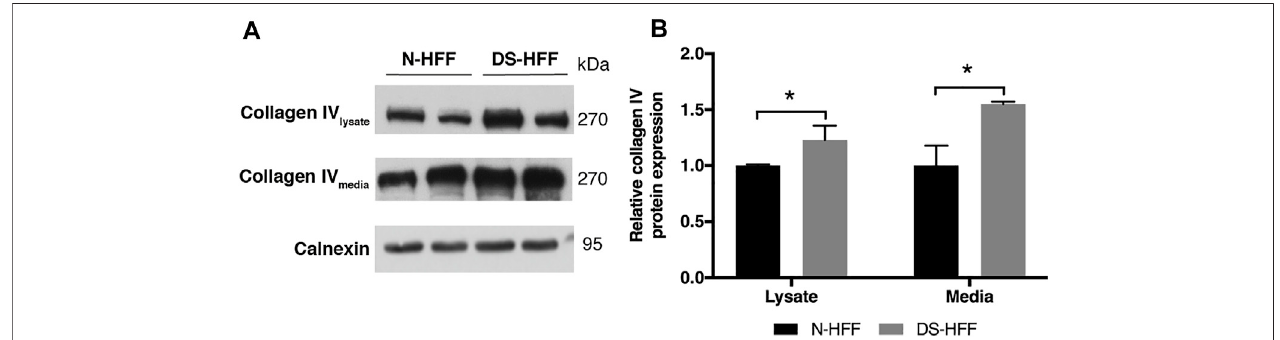
FIGURE 5 | Trisomic samples show a signi fi cant increase of collagen IV protein in cell lysates and culture media. (A) Representative immunoblotting of collagen IV protein detected in cell lysates and media of three N-HFF and three DS-HFF samples. Calnexin was used as a loading control. (B) Densitometric analysis from three different experiments. Results are expressed as relative mean values ± SEM from three N-HFF and three DS-HFF samples. * p -value ≤ 0.05.